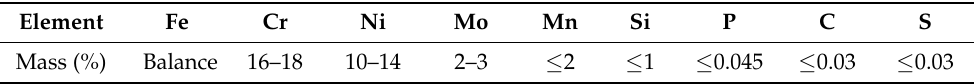
Table 1. Chemical components of the 316L-0407 powder used for experiments. Element Fe Cr Mass (%)